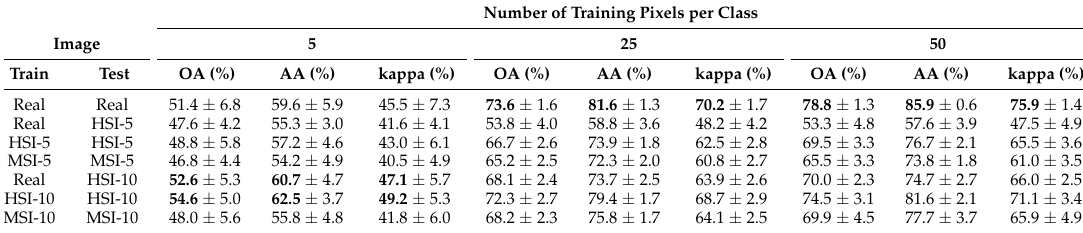
Table 5. Comparison of classification performance on real and reconstructed hyperspectral